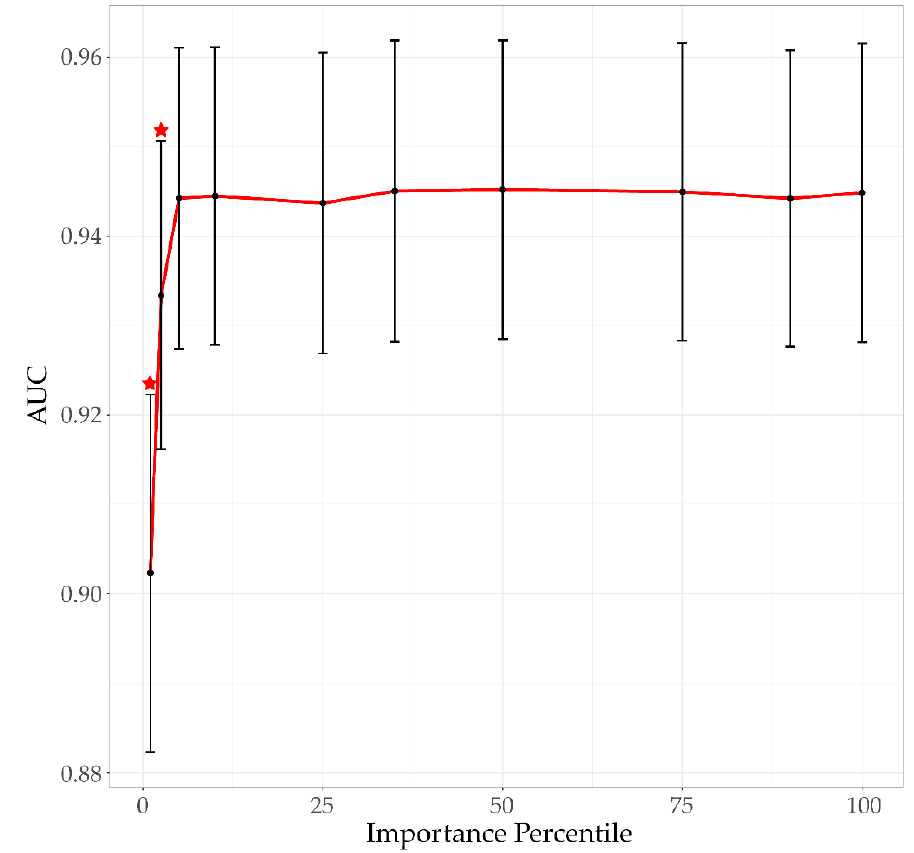
Figure 9. AUC comparison using feature selection. Error bars represent a 95% confidence interval calculated using 2000 stratified bootstrap replicates. Stars indicate statistical difference in ROC curves in comparison to using the entire feature set.